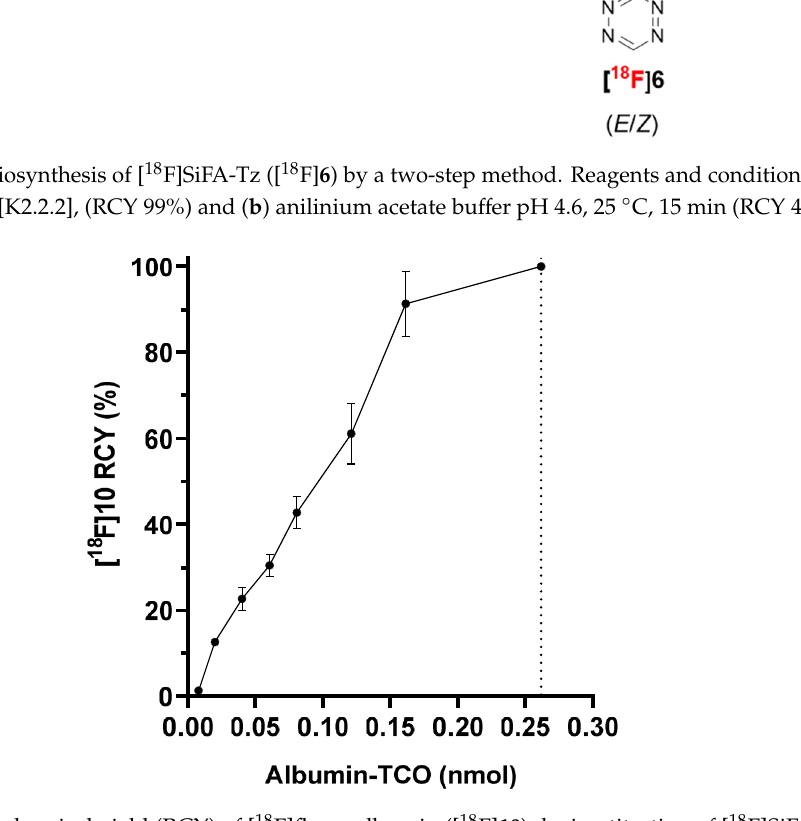
Figure 1. Radiochemical yield (RCY) of [ 18 F]fluoroalbumin ([ 18 F] 10 ) during titration of [ 18 F]SiFA-Tz ([ 18 F] 6 ), with albumin-TCO revealed a maximal radiochemical yield of >99% with 0.26 nmol of albumin-TCO.